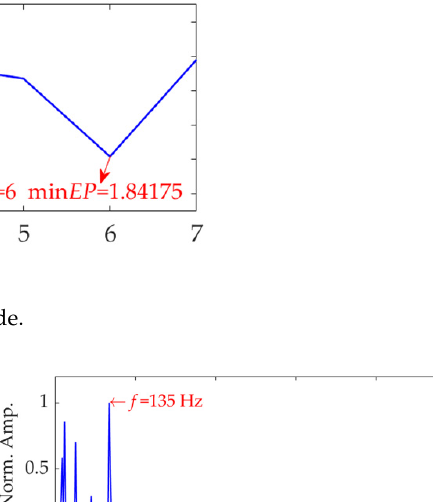
Figure 23. Relationship between the α value and ( a ) the EP index value and ( b ) order number of